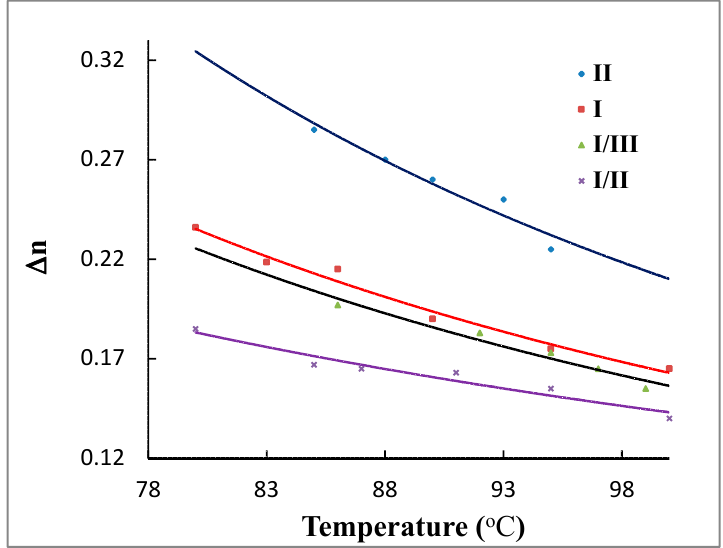
Figure 11. Temperature dependence of birefringence for materials I , II , I / II and I / III at 543 nm. The dots are the measurements of n o and n e , and the solid line corresponds to the fitting by using Cauchy dispersion relation.